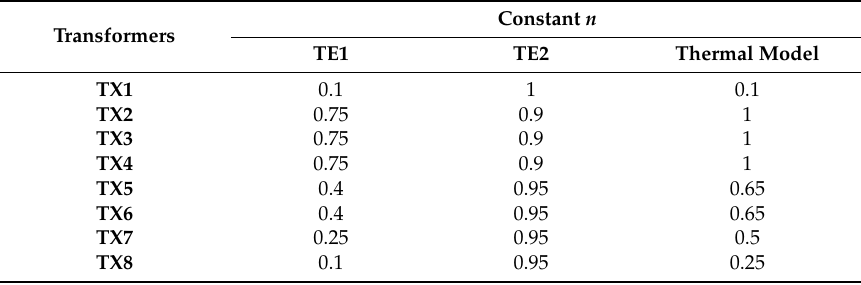
Table 3. Constant n used in this